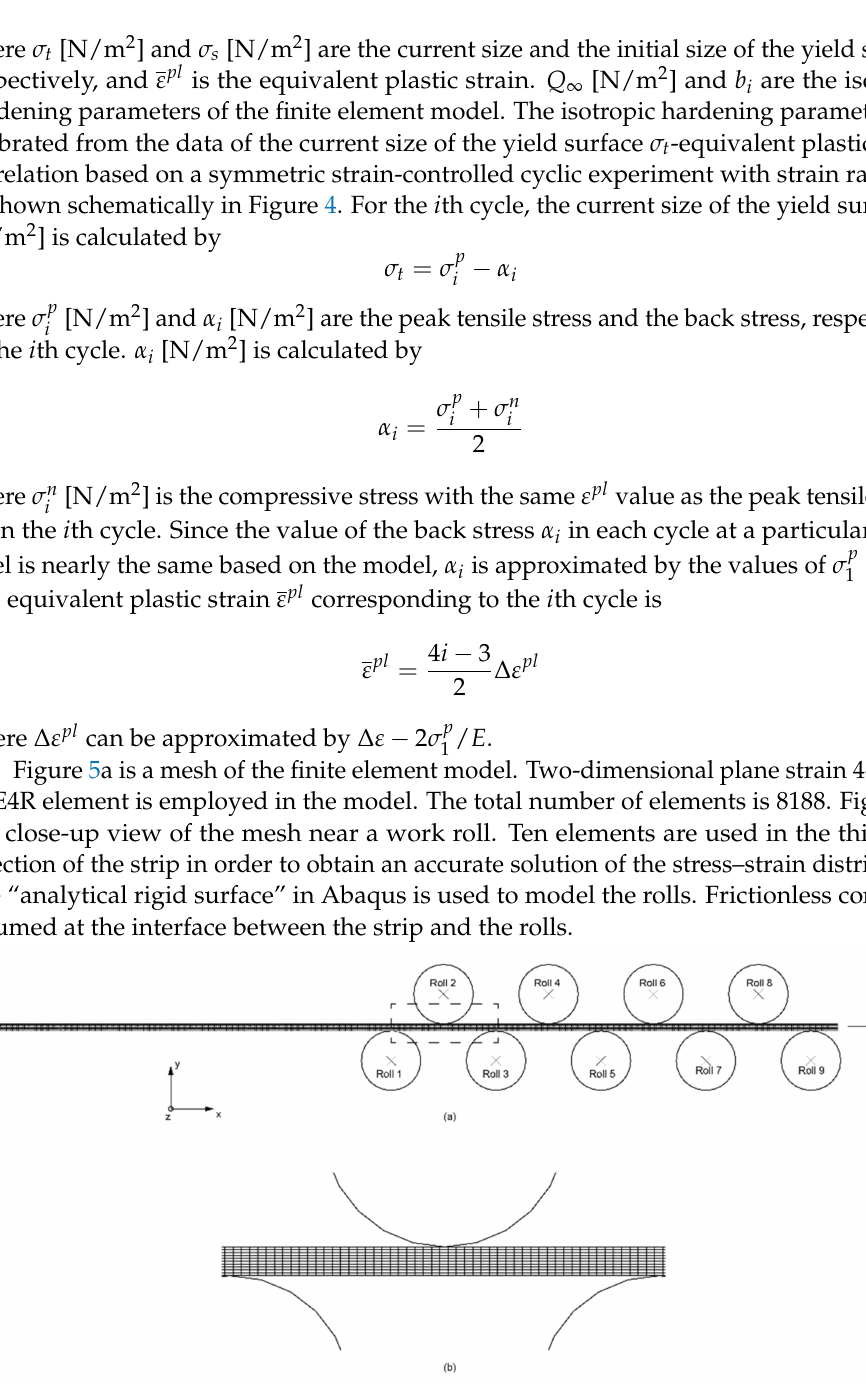
Figure 5. ( a ) A finite element model. ( b ) A close-up view of the mesh near a